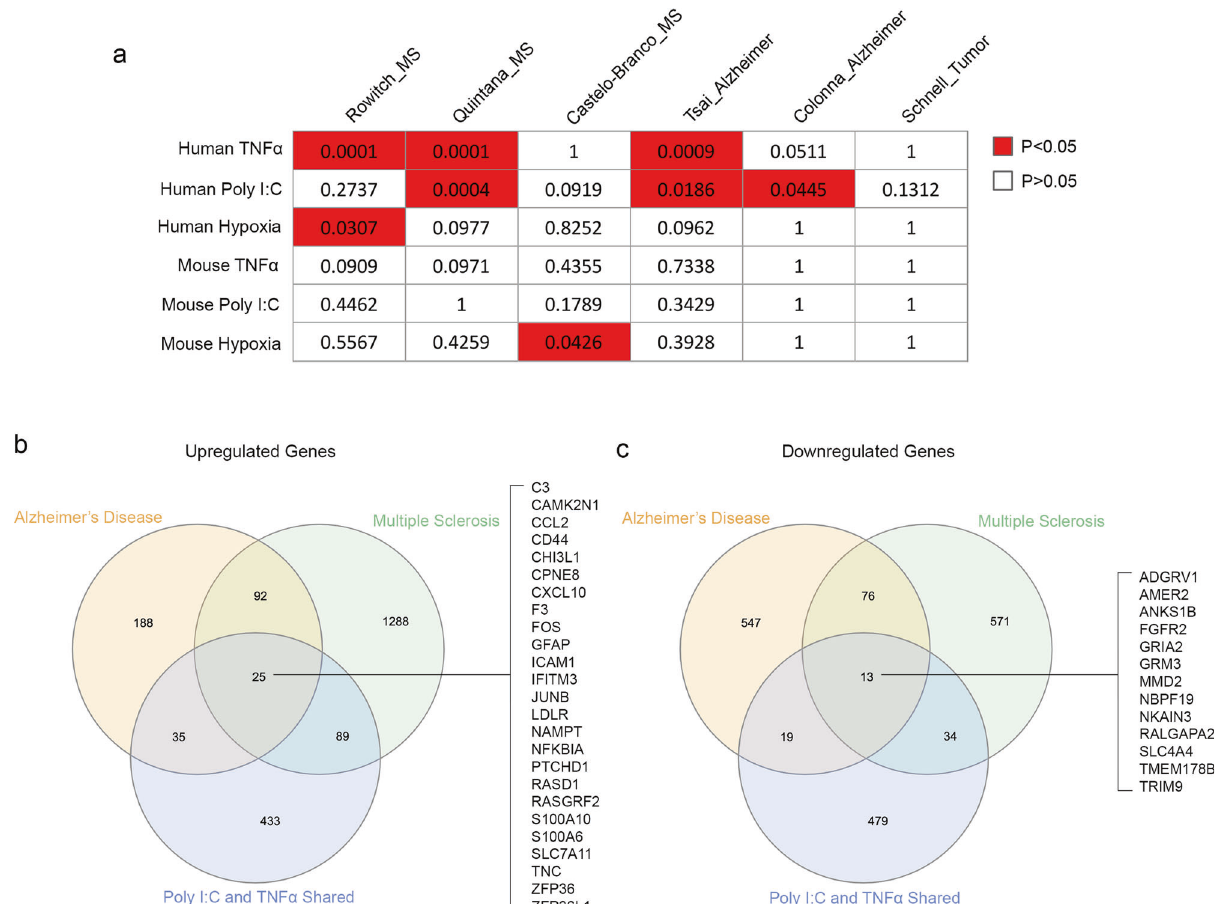
Fig. 8 Core in fl ammatory astrocyte genes shared in Alzheimer ’ s disease, multiple sclerosis, and poly I:C and TNF α treatments in humans. We analyzed single-cell RNA-seq data from Alzheimer ’ s disease patients, multiple sclerosis patients, and healthy controls. We compared the differentially regulated genes in astrocytes in these diseases with the hypoxia-, poly I:C-, and TNF α -induced genes we identi fi ed in cultures of human and mouse astrocytes. a Signi fi cant concordant gene expression changes are present in disease conditions in vivo and in astrocyte treatments in vitro. To test whether treatment A and disease B exhibited concordant gene expression changes, we counted the number of genes in the following four categories: (1) upregulated in treatment A and upregulated in disease B; (2) upregulated in treatment A and downregulated in disease B; (3) downregulated in treatment A and downregulated in disease B; and (4) downregulated in treatment A and upregulated in disease B. We used the number of genes in each of the four categories in a contingency table and used two-sided Fisher ’ s exact test to detect signi fi cant concordance. MS, multiple sclerosis. b , c We found 38 core in fl ammatory astrocyte genes shared by Alzheimer ’ s disease, multiple sclerosis, and poly I:C and TNF α treatment in humans, 25 of which are upregulated ( b ) and 13 are downregulated ( c ) in diseases and